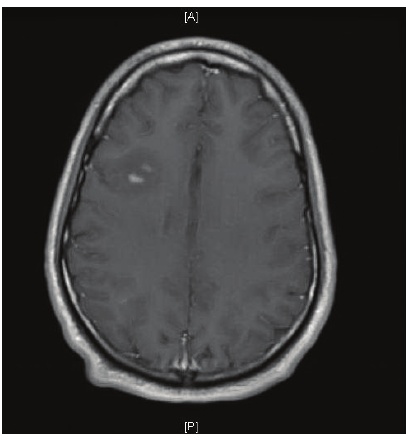
Figure 1: A T1-weighted postgadolinium magnetic resonance image demonstrating two nodular foci of enhancement with surrounding vasogenic edema.